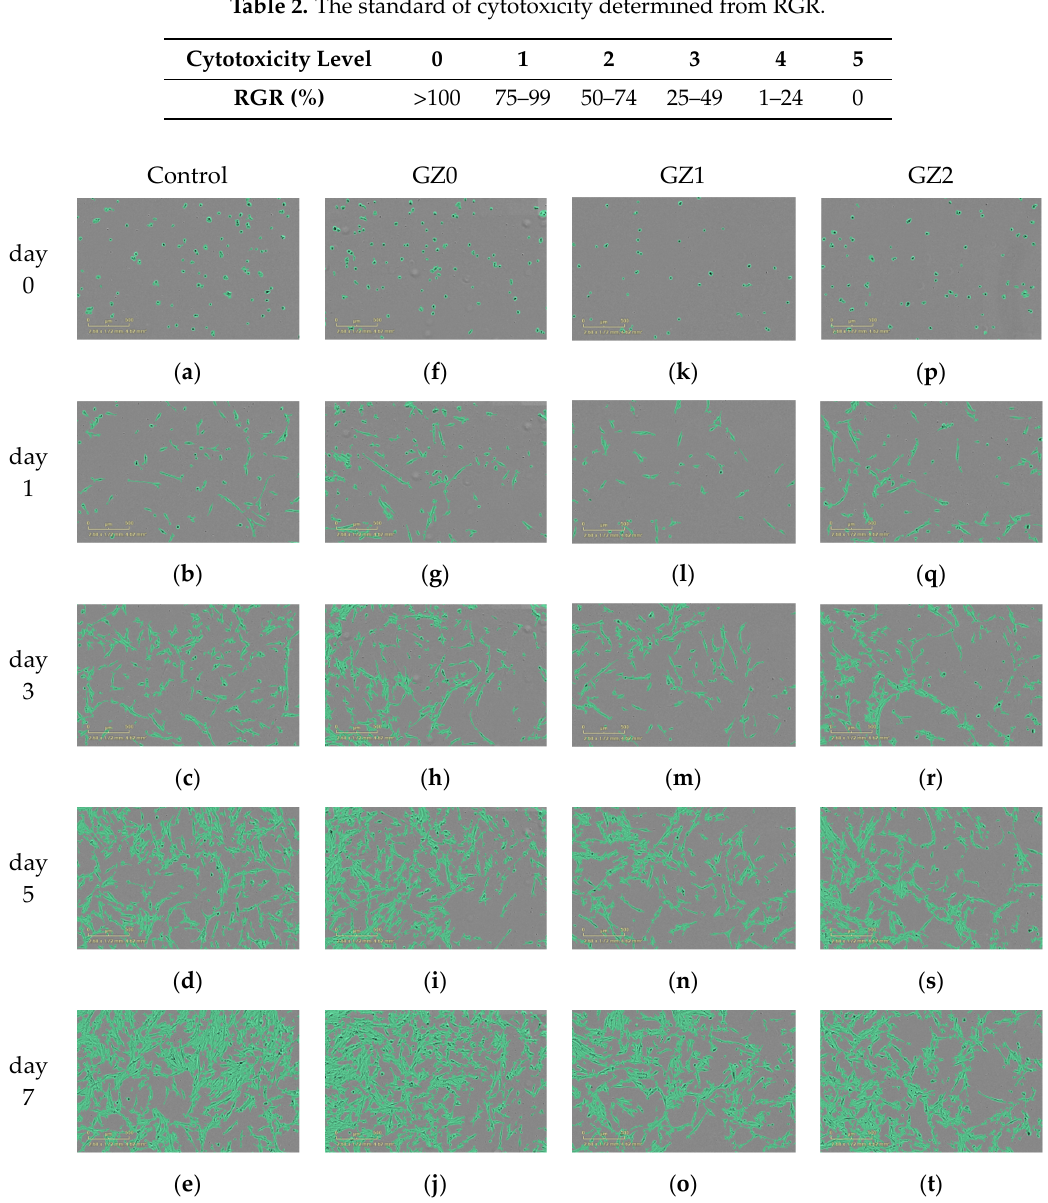
Table 2. The standard of cytotoxicity determined from RGR.